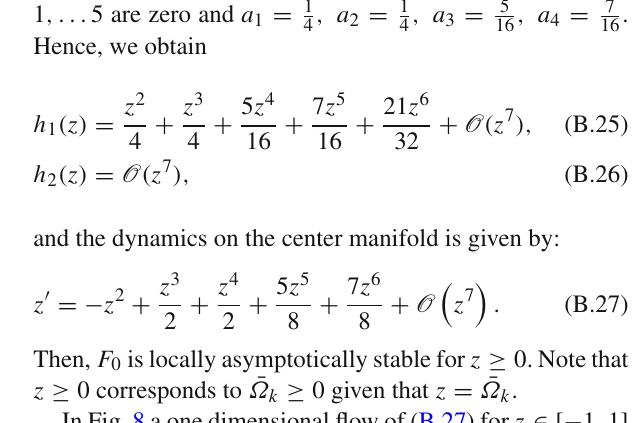
Fig. 11 Two dimensional flow for (B.101), (B.102). The origin is